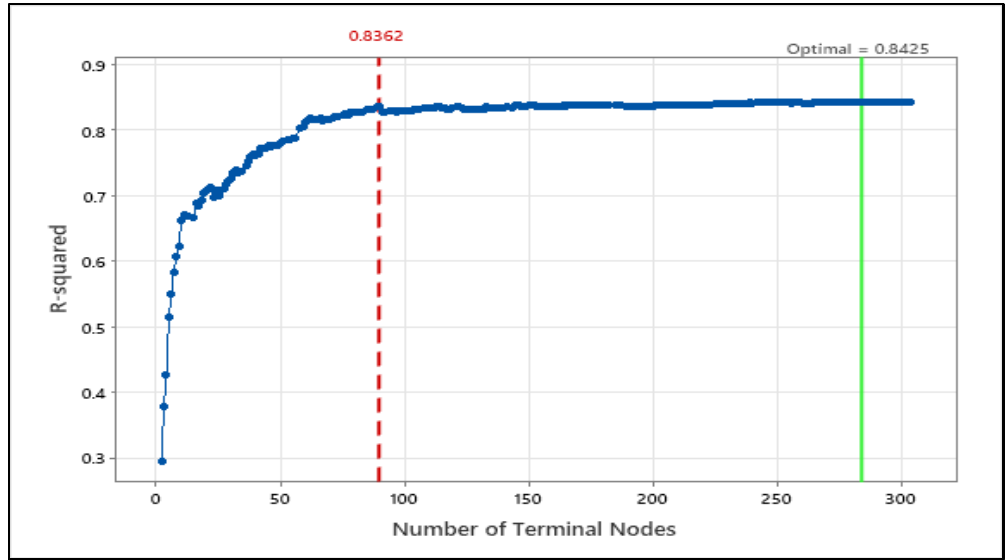
Figure 5. R-Squared Values vs. Number of Terminal Nodes.